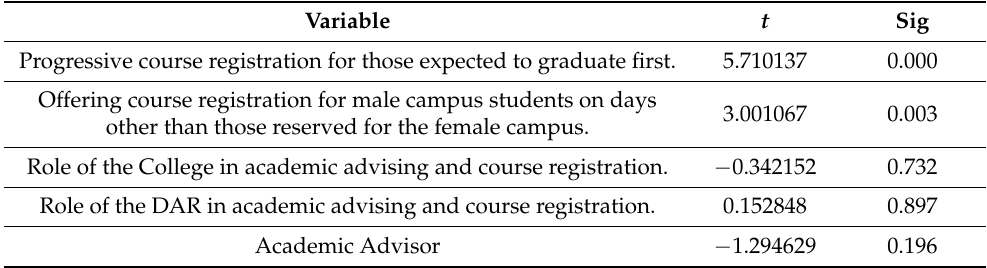
Table 17. t -Test results for study variables by